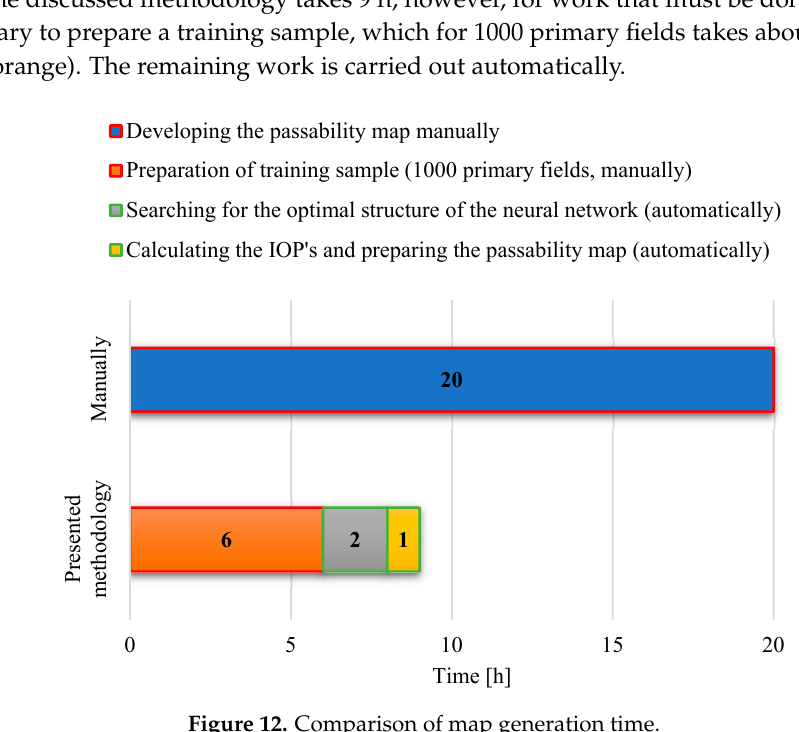
Figure 12. Comparison of map generation time.